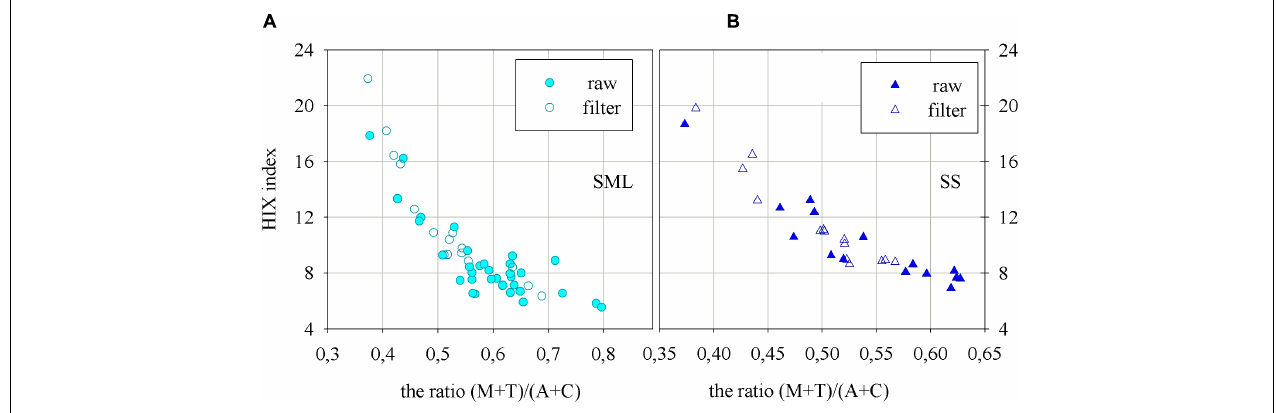
FIGURE 5 | The relation between the ratio of fluorescence intensities of the main components of FDOM, ( M + T )/( A + C ) , and humification index, HIX , for the (A) SML and (B) SS water.